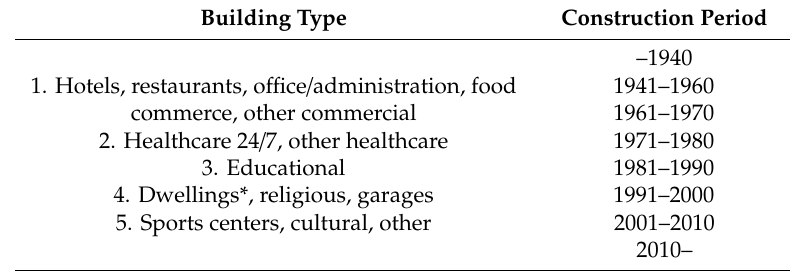
Table 2. The building types and construction periods used to obtain archetype NRBs, which represent the non-residential BS of Gothenburg, i.e., each building type exists for each period, yielding a total of 40 NRB building